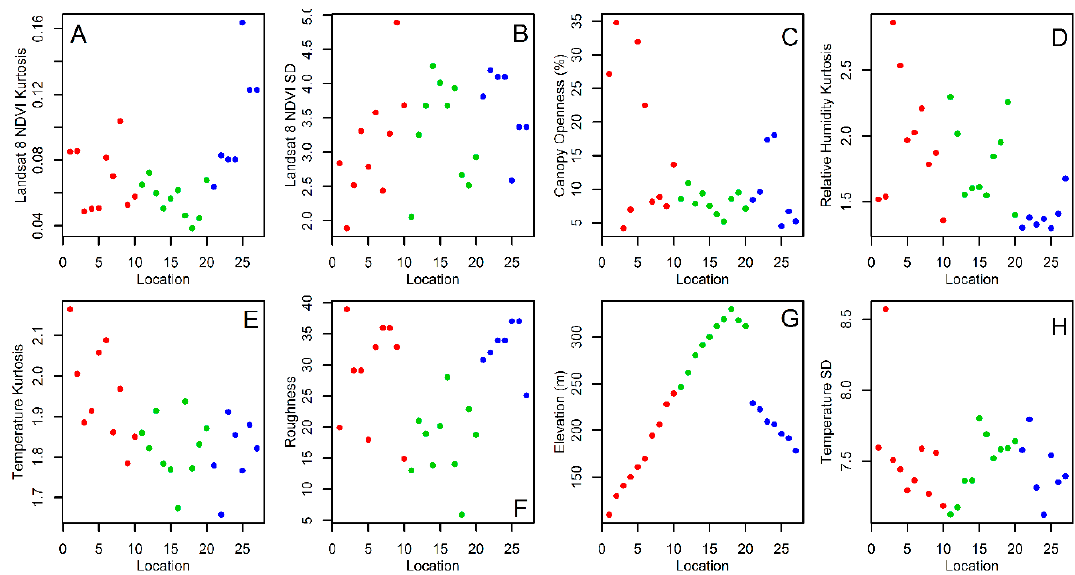
Figure 7. Environmental covariates associated with Tripteroides bambusa spatial abundance at the sampling locations. ( A ) SD of Landsat 8 NDVI, ( B ) Landsat 8 NDVI kurtosis, ( C ) mean canopy openness, ( D ) relative humidity kurtosis, ( E ) Ovitrap water temperature kurtosis, ( F ) roughness, ( G ) elevation, and ( H ) SD of ovitrap water temperature. In all plots, numbers and colors represent, respectively, the sampling locations and transects described in Figure 2.